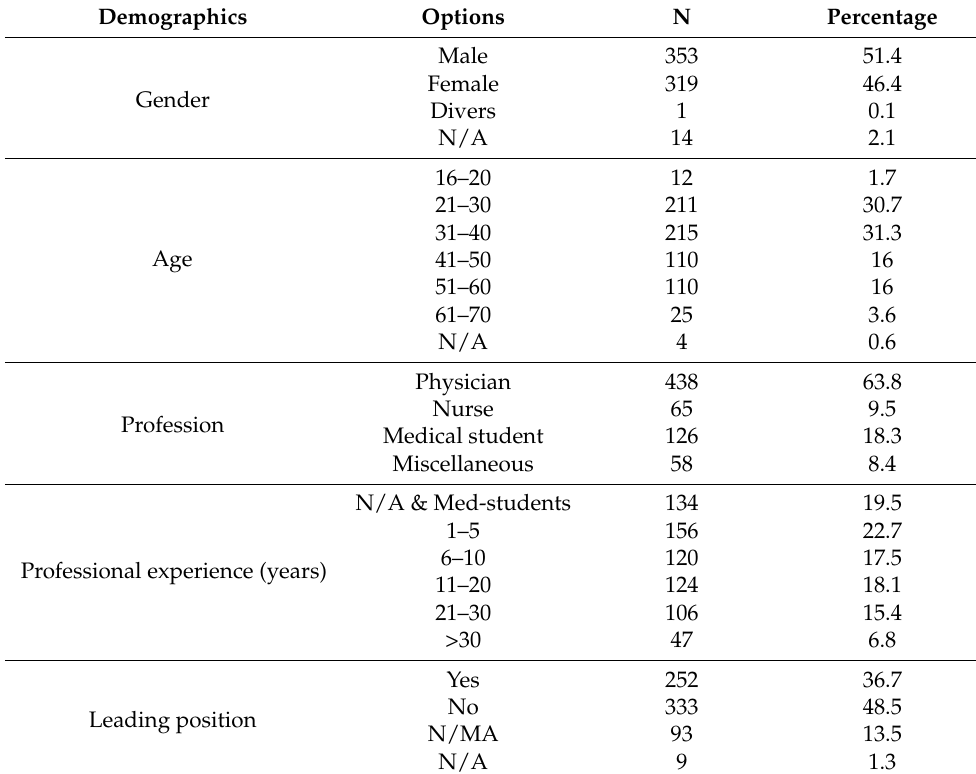
Table 1. Demographic information of HCPs who participated in the survey.